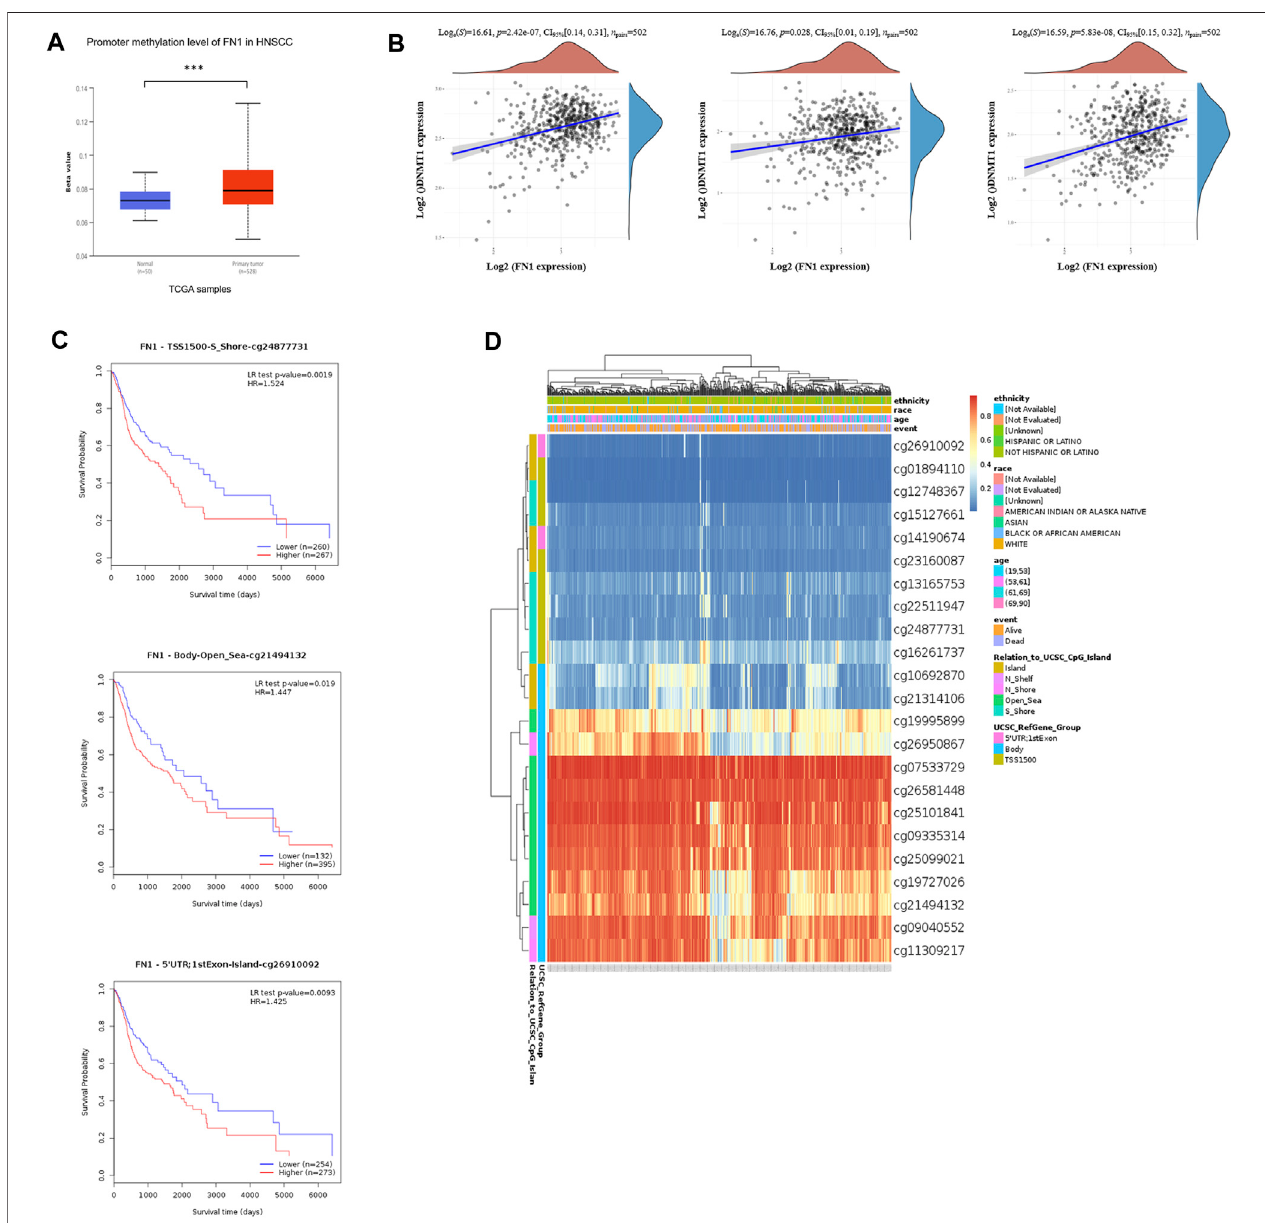
FIGURE 3 | Hypermethylation of FN1 and its prognostic value in HNSCC. (A) FN1 was signi fi cantly hypomethylated in HNSCC tissues compared with the normal group. (B) FN1 expression was positively correlated with three crucial DNA methyltransferases ’ (DNMT1, DNMT3A, and DNMT3B) levels. (C) Higher methylation